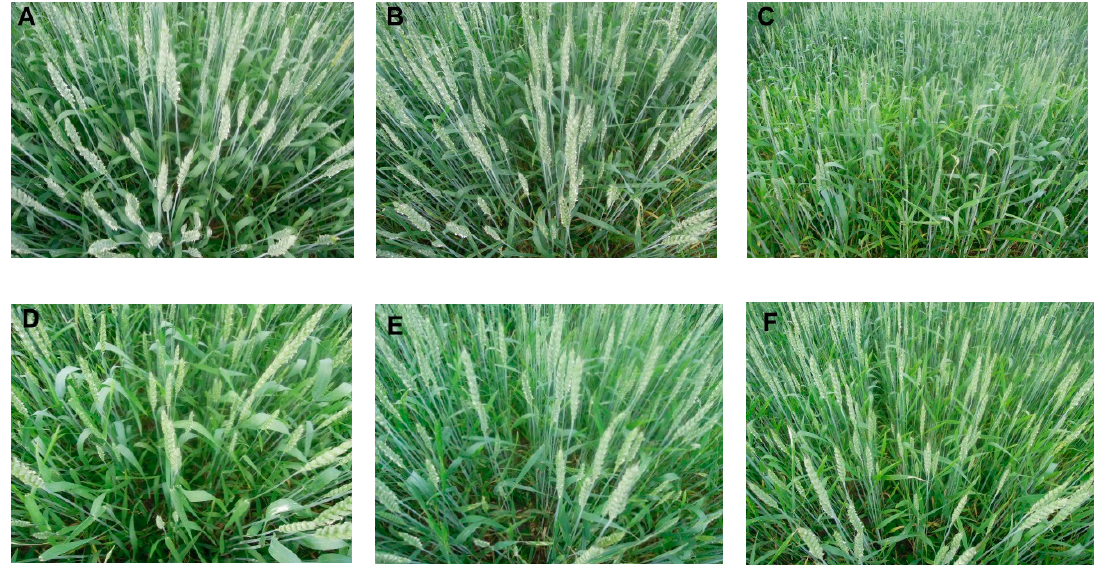
Figure 3. Selected varieties of spring wheat grown under the organic system—flowering phase (BBCH 65–68) in Osiny. ( A )—Arabella, ( B )—Brawura, ( C )—Cytra, ( D )—Kandela, ( E )—Katoda, ( F )—Waluta.